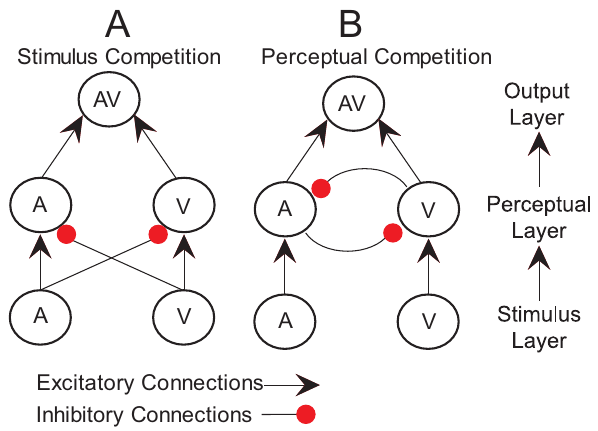
Figure 6. A schematic representation of the computational models of MSI: the model is organized in three layers: stimulus, perceptual and output with excitatory connections (black arrows) or inhibitory connections (red dots) The primary difference between models is whether ( A ) stimuli directly suppress perceptual representation of cross-modal stimuli or ( B ) perceptual representations compete with one